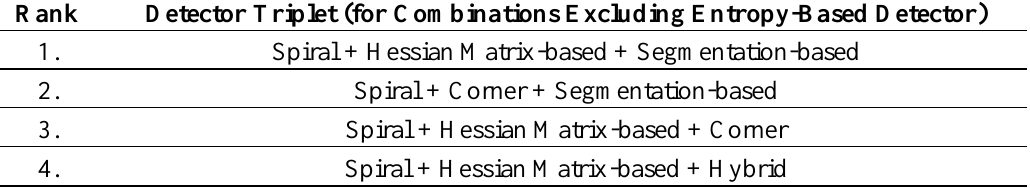
Table 6. Some other promising detector triplets in terms of detector